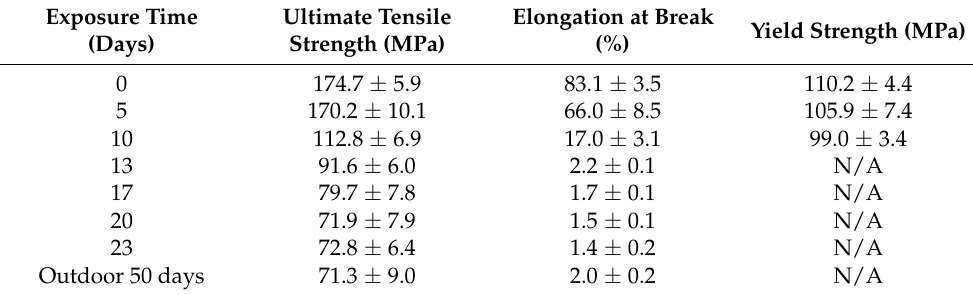
Figure 7. ( a ) Stress–strain curves of OMO samples after weathering tests. ( b ) Raman intensity ratio as a function of accelerated weathering time. Table 4. Tensile testing results of OMO samples before and after the weathering tests.